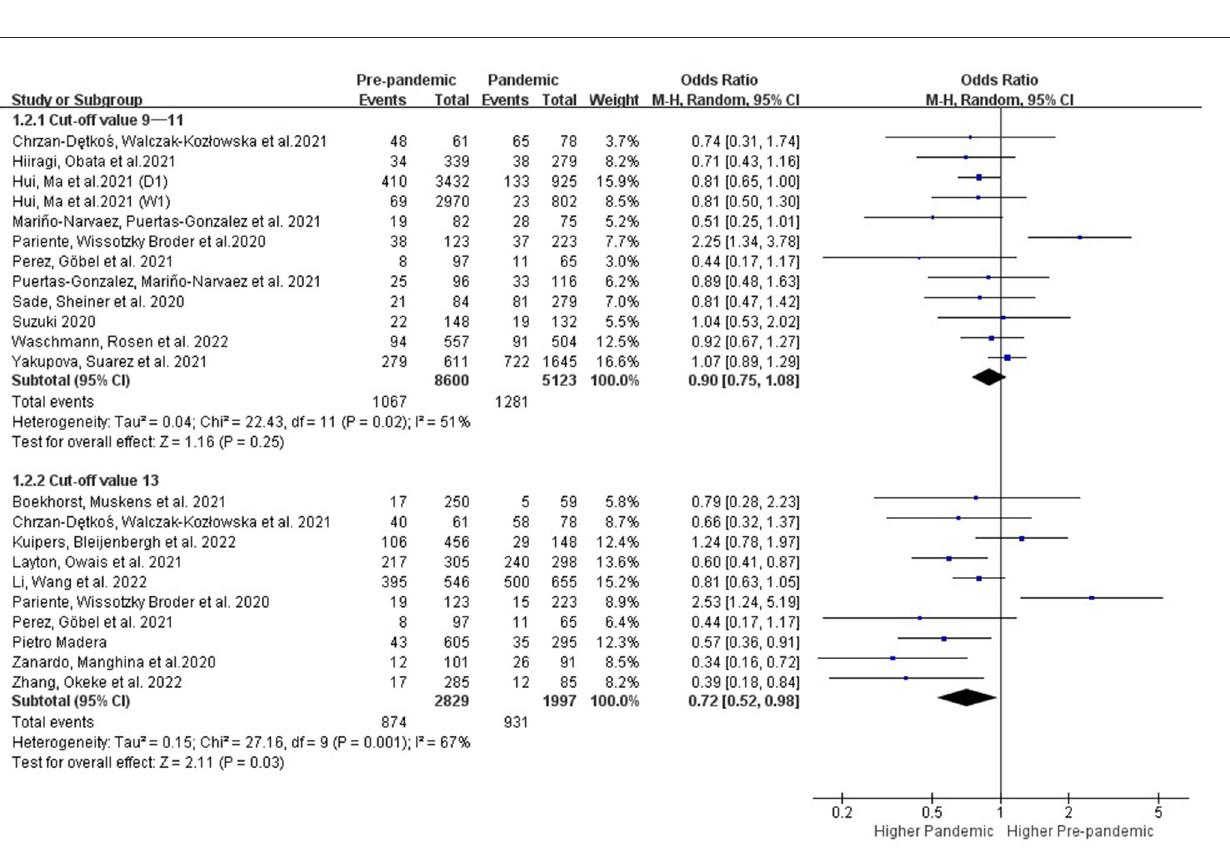
FIGURE3 Subgroup analysis comparing the prevalence of PPDS before and during the COVID-19 pandemic according to the cut-off values of EPDS.